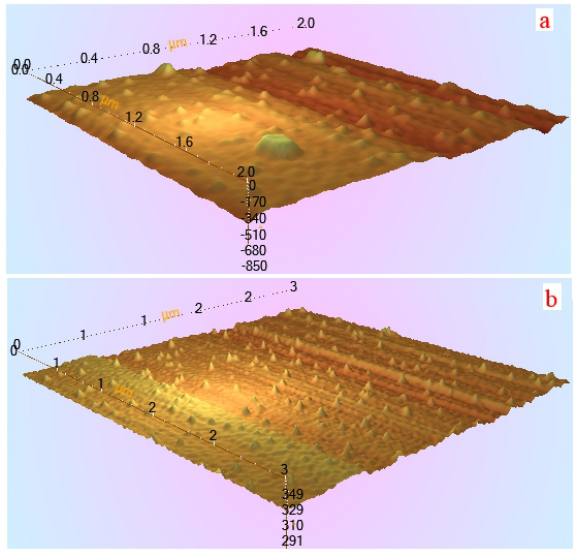
Fig. 5. AFM of nanoparticles a) ZnO b) WO-ZnO